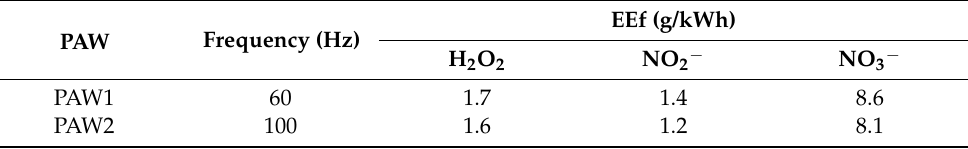
Table 2. Energy efficiency (EEf) values used for the generation of H 2 O 2 , NO 2 − , and NO 3 − in PAW1 and